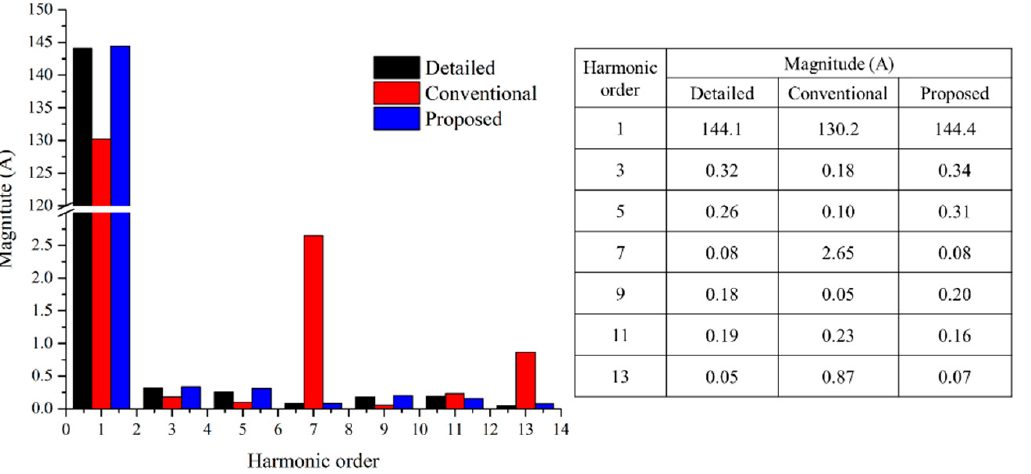
Figure 5. FFT results of phase u current at rated speed and rated load